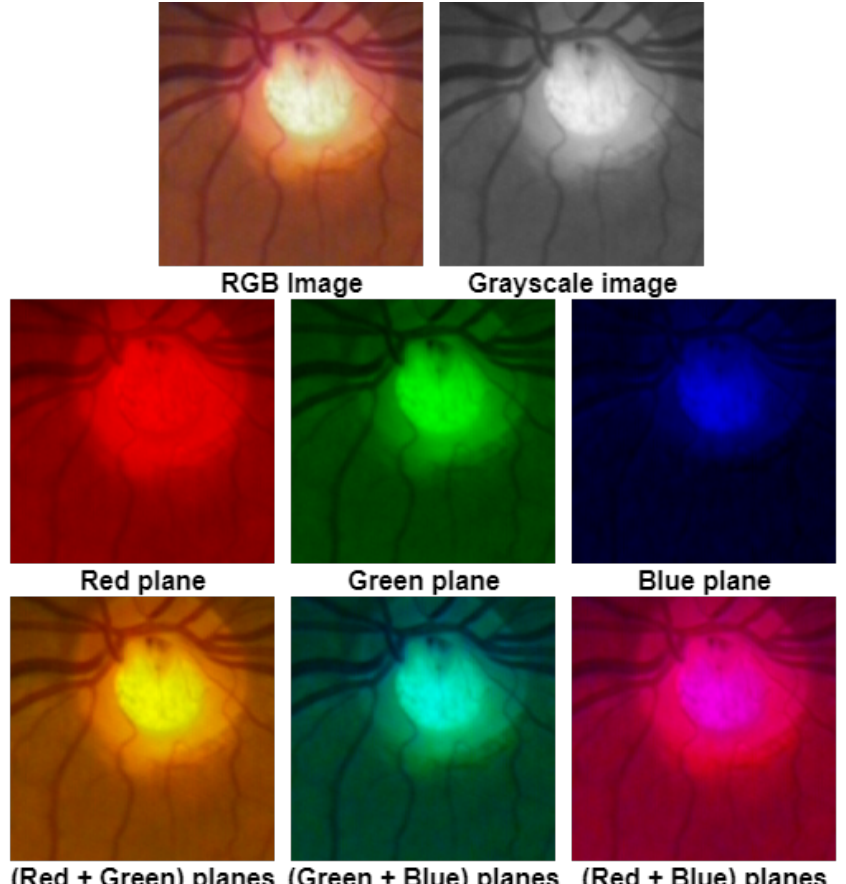
Figure 8. Color planes extraction used for